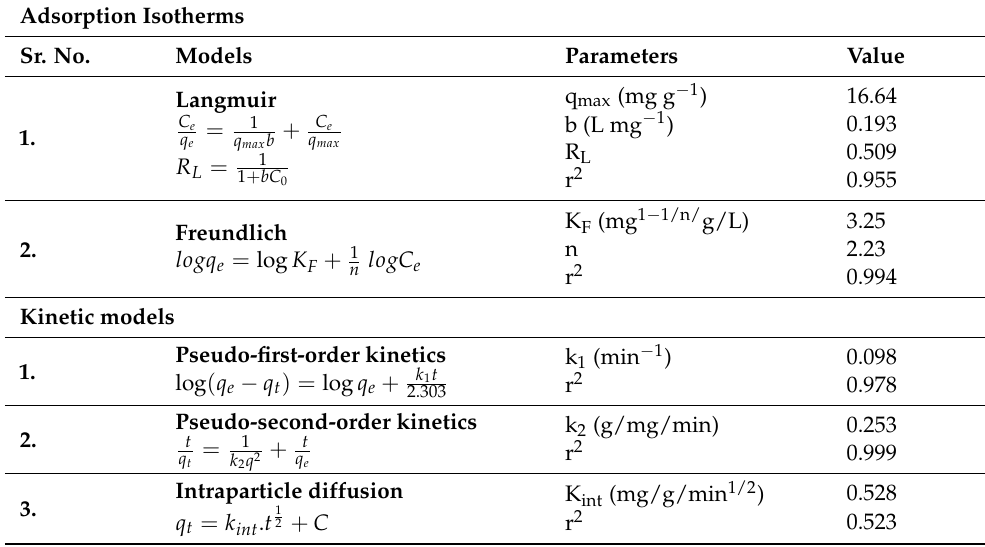
Table 1. Adsorption isotherms and Kinetic model—equations and